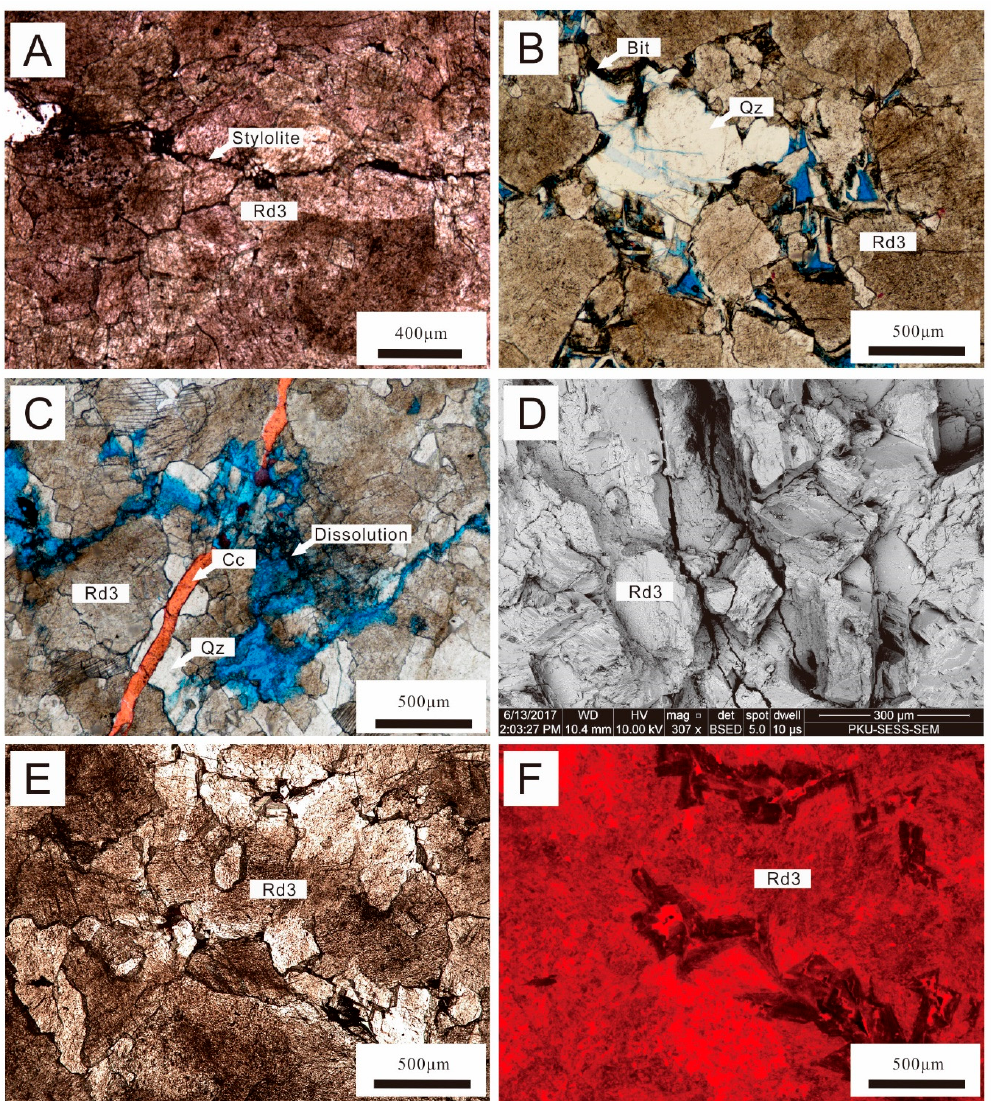
Figure 6. Rd3 dolomite. ( A ) Burial stylolite cross-cutting Rd3 (Well Hanshen1; P 2 q ); ( B ) quartz (Qz) in the intercrystalline pores of Rd3 dolomite with bitumen (Bit) (Xinjigu; P 2 q ); ( C ) calcite cements (Cc) in fracture (Fx) cross-cutting Qz and Rd3, with late-phase dissolved Fx cross-cutting Qz, Rd3, and Cc (Zhangcun; P 2 q ); ( D ) photomicrograph of coarse and curved crystals of Rd3 dolomite (SEM) (4988.5 m; Well Hanshen1; P 2 q ); ( E , F ) paired photomicrographs of medium-to-coarse crystalline, nonplanar-a dolomite. Rd3 dolomite shows strong dull-red luminescence under CL (Zhangcun; P 2 q ). Zebra fabrics in replacement dolomite (Rd) and hydraulic fractures were filled by white dolomite cement (Cd), and were well developed in proximal areas (~25% by abundance) in the Qi1 and Qi2 members. In contrast, Cd dolomite only appeared as a void-filling mineral in the host Rd dolomite in distal areas (~5% by abundance) at the top of the Qi1 member and the bottom of the Q2 member. The saddle Cd dolomite crystals showed a strong sweeping extinction under cross- polarized light and the residual pores were filled by later calcite cementation (Figure 7B). Cd dolomite exhibited dull-red luminescence with a rim characterized by bright CL zonation, while void-filling calcite showed non-luminescence (Figures 7C–F).